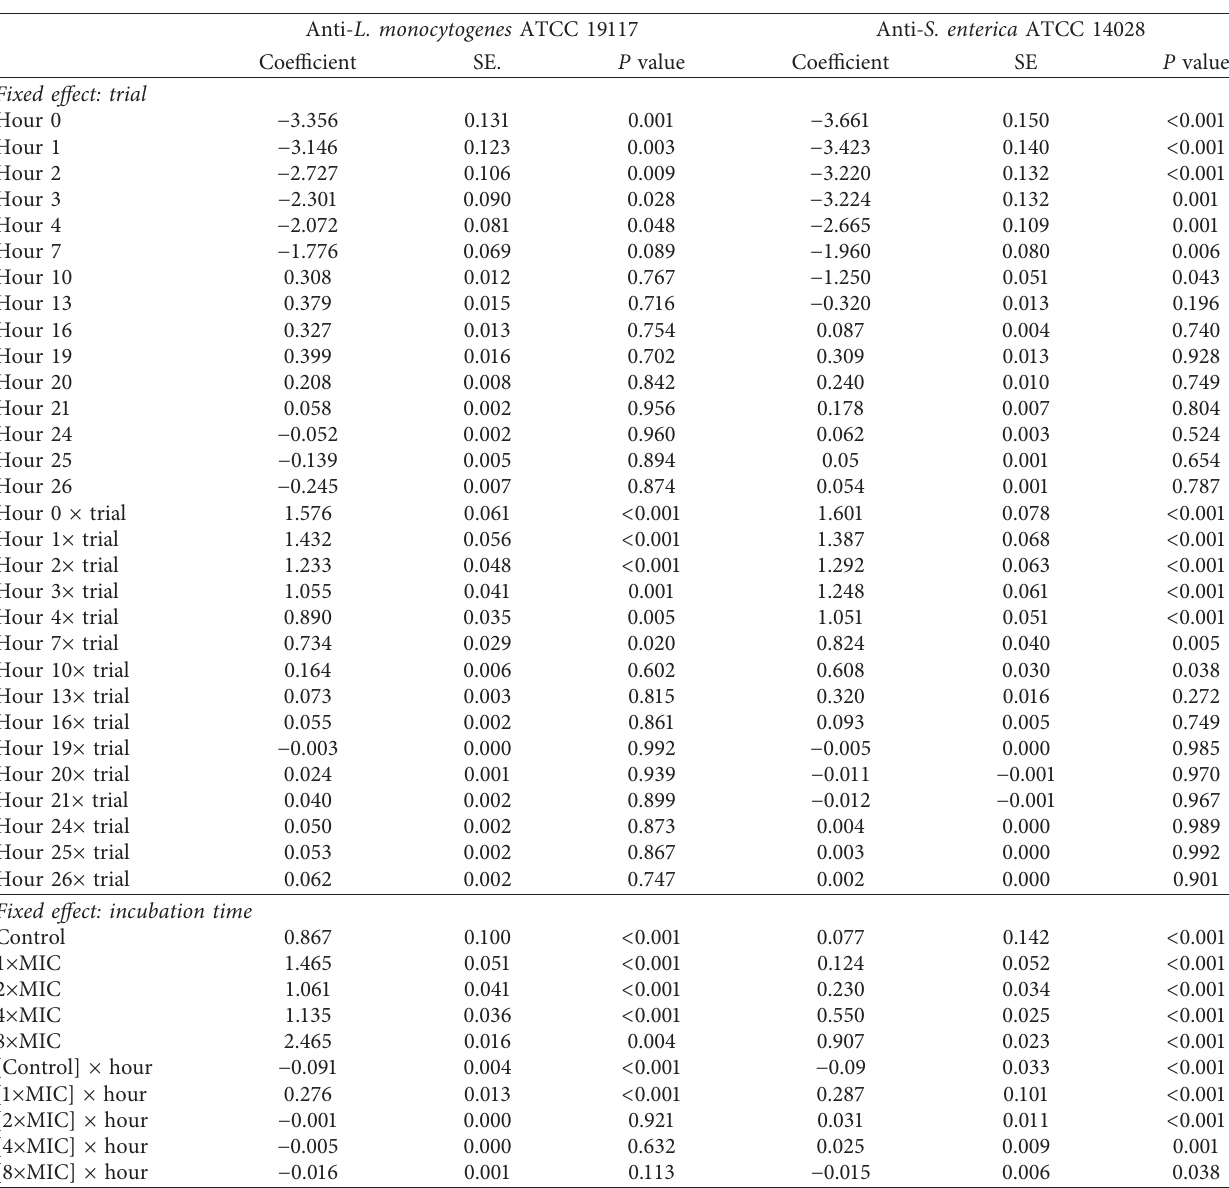
Table 7: Relationship between treatments (trials) and incubation time ( h ) and their interactions with the L. monocytogenes ATCC 19117 and S. enterica ATCC 14028